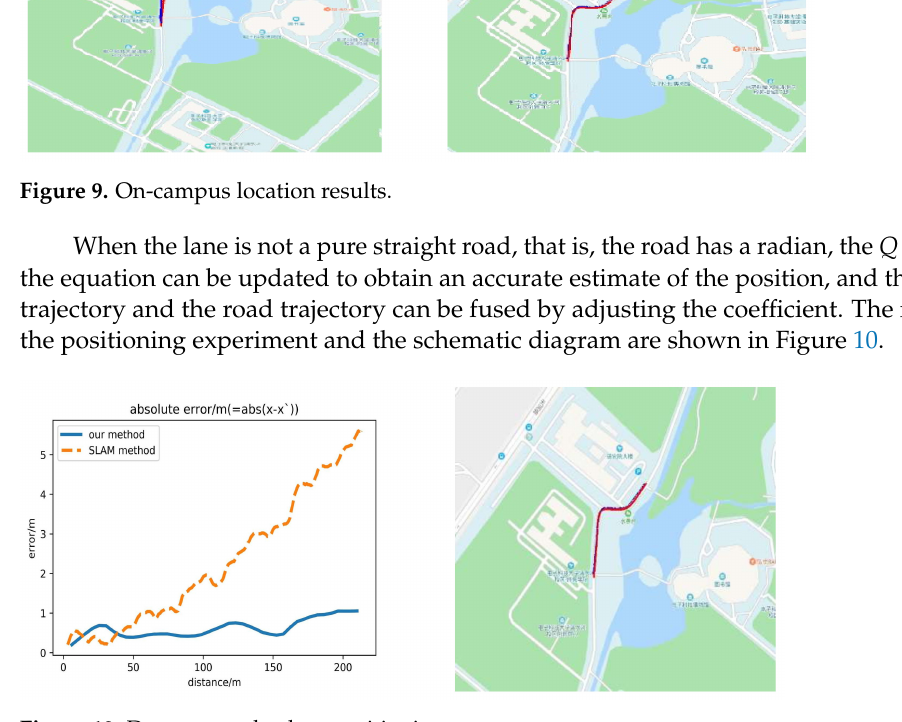
Figure 10. Detour test absolute positioning error.